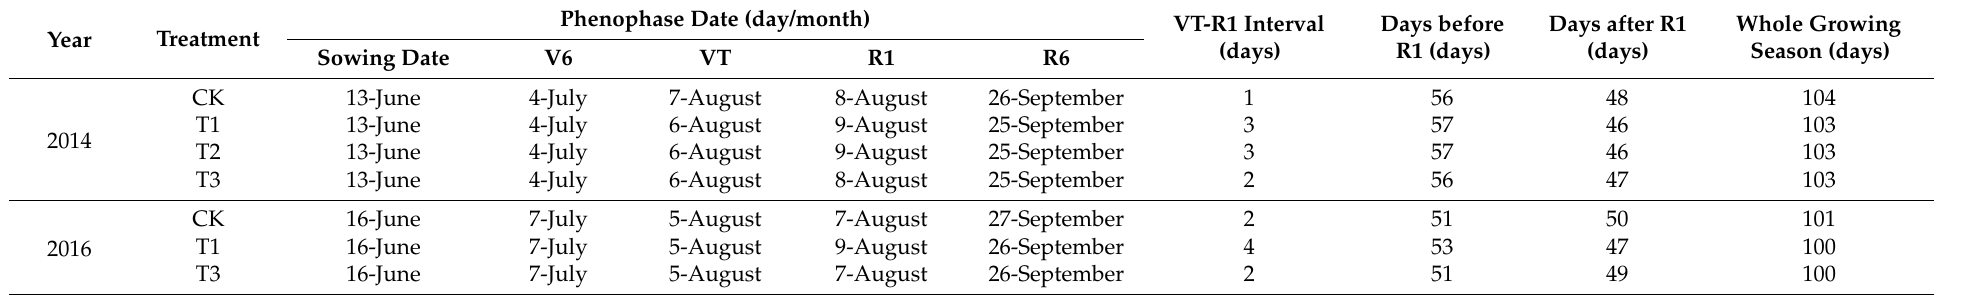
Table 1. Phenology changes as affected by nocturnal warming during 2014 and